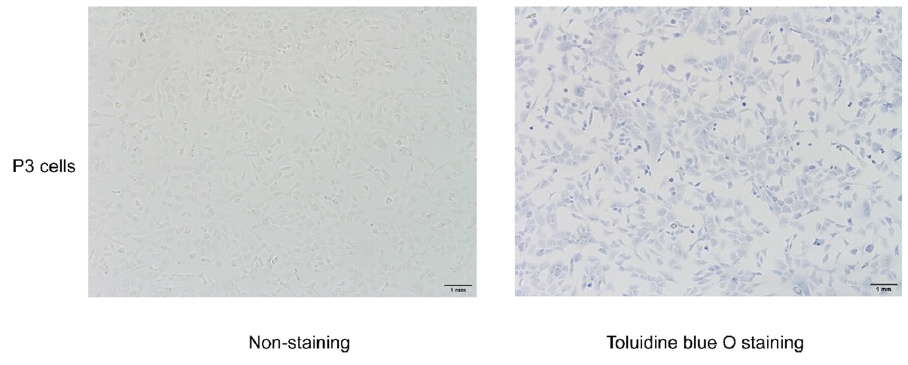
Figure 6. Toluidine blue O staining for chondrocytes.